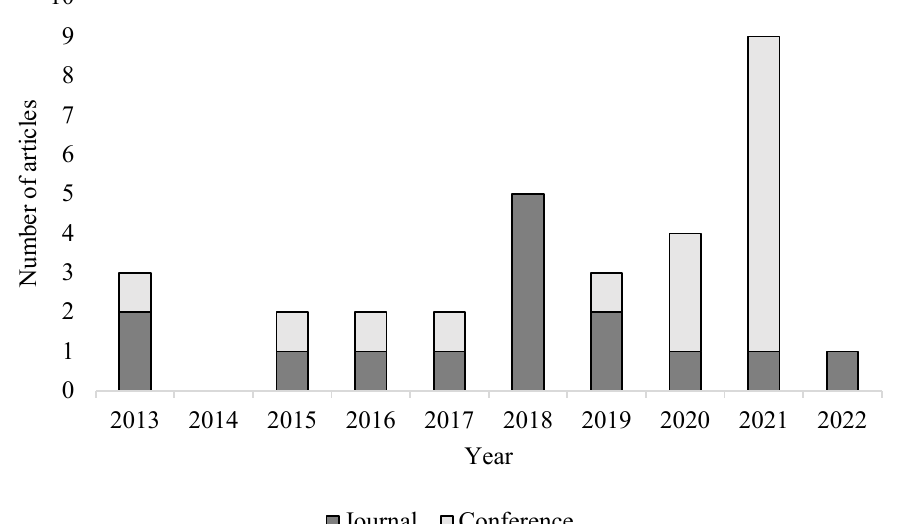
Figure 2. Article publication type over time.